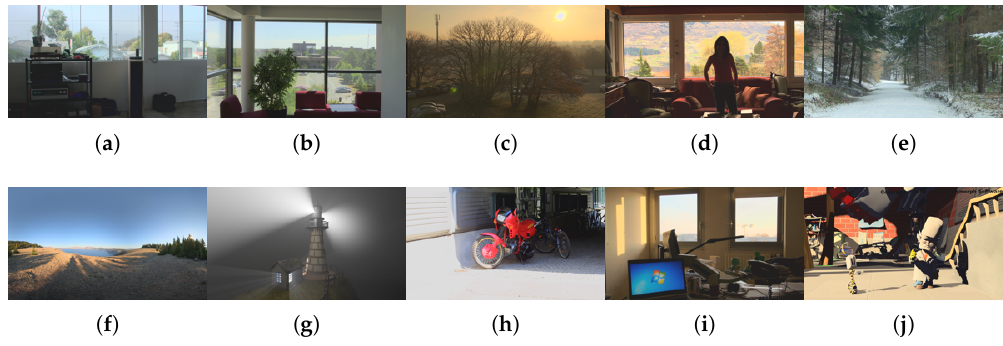
Figure A1. Tone-mapped version (Reinhard et al. TMO [54]) of Narwaria et al. reference images. From left to right and from top to bottom: ( a ) Apartment_float_o15C ( b ) bausch_ lot ( c ) carpark_ ivc ( d ) CD1_serie2 ( e ) forest_path ( f ) lake ( g ) LightHouse072 ( h ) moto ( i ) office_ivc ( j ) outro022168.